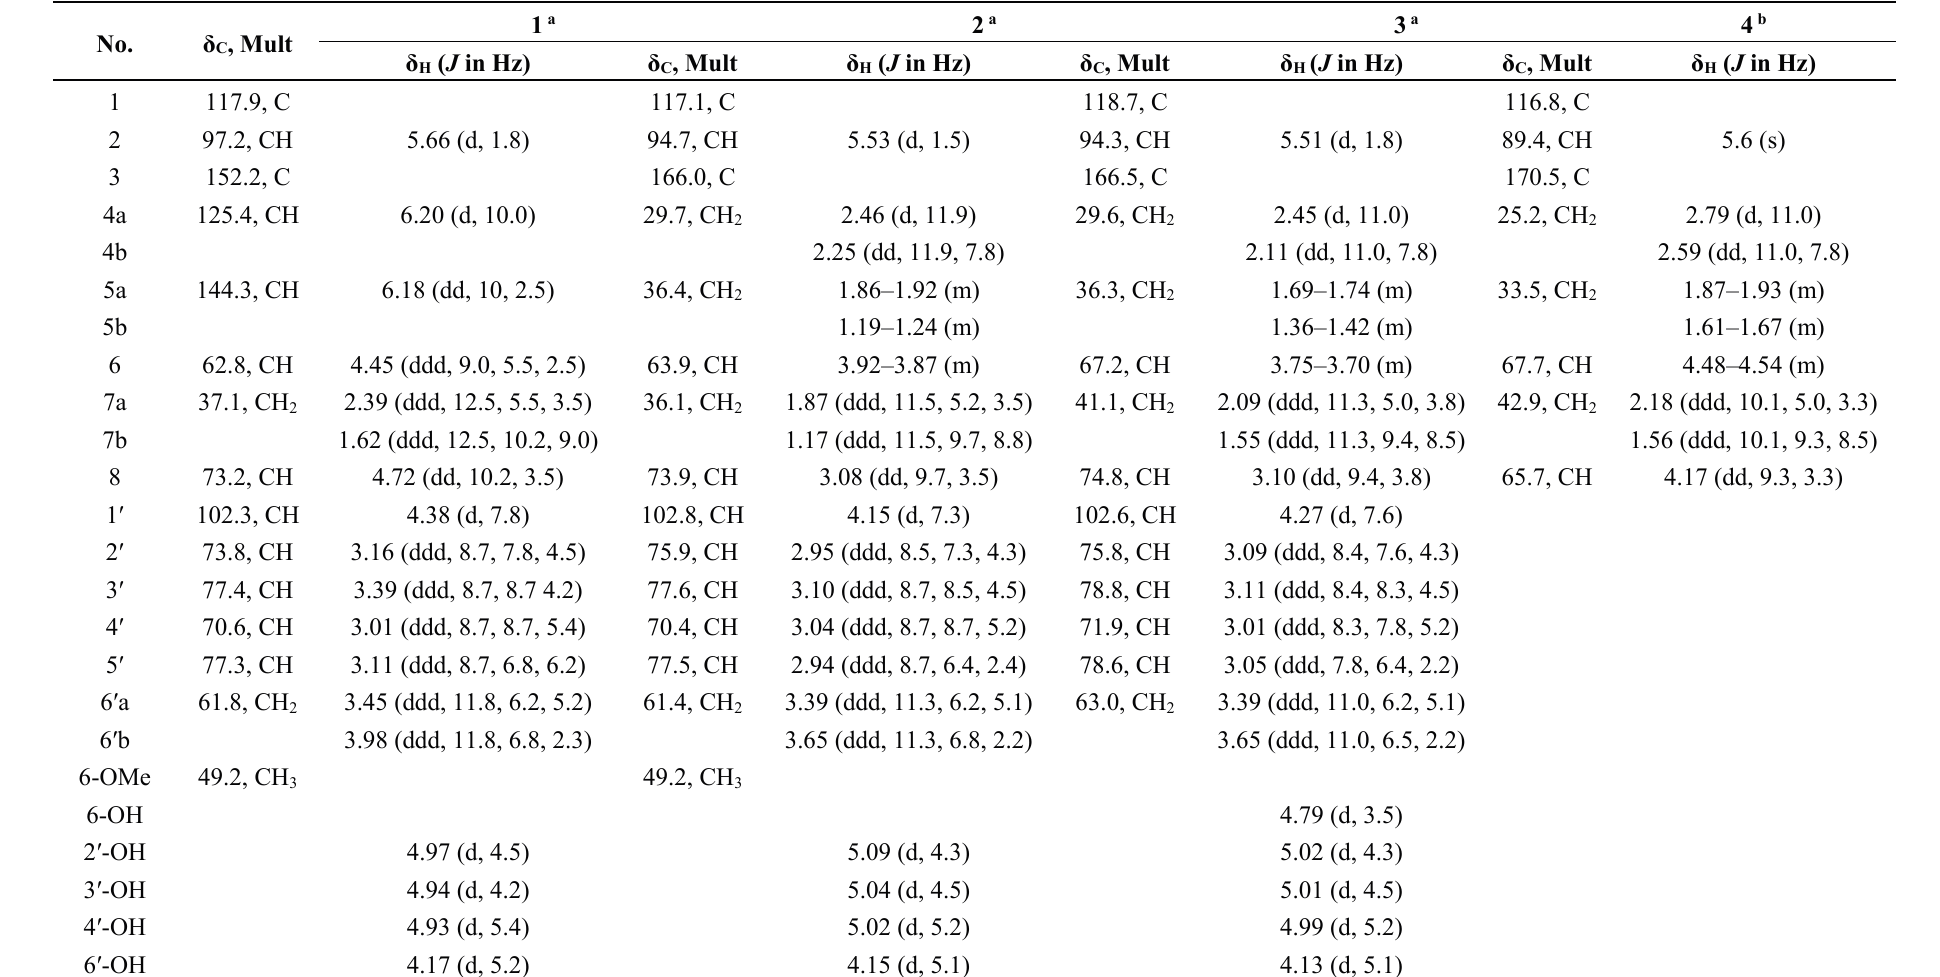
Table 1. 1 H- and 13 C-NMR data of 1 – 4